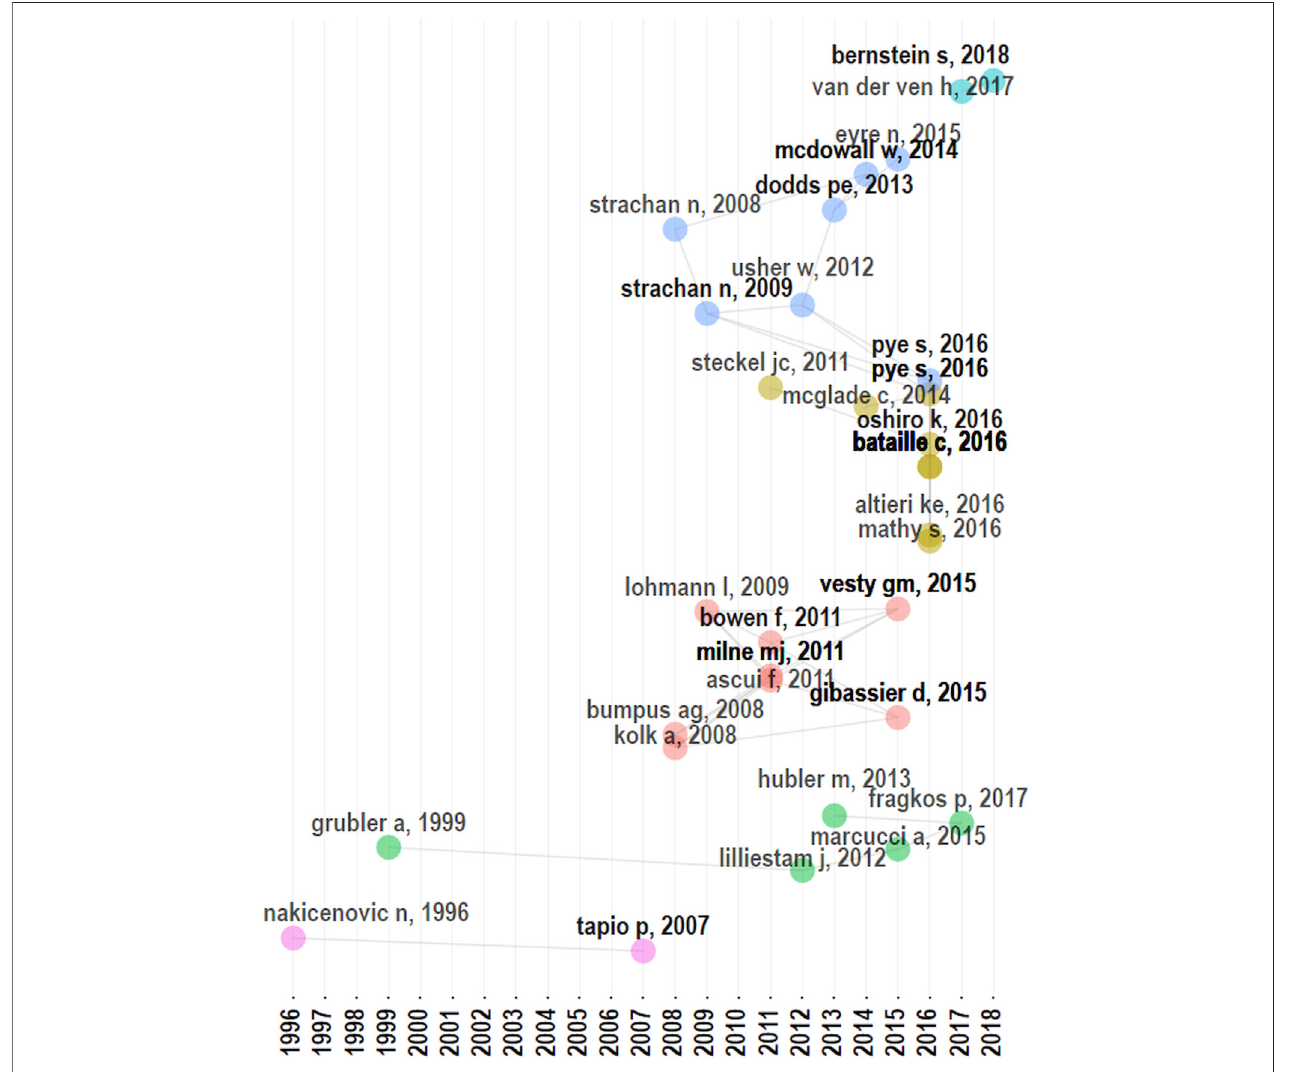
FIGURE 1 | Bibliometric historiography graph showing the historical evolution of the most-cited work: with parameter node value 30.